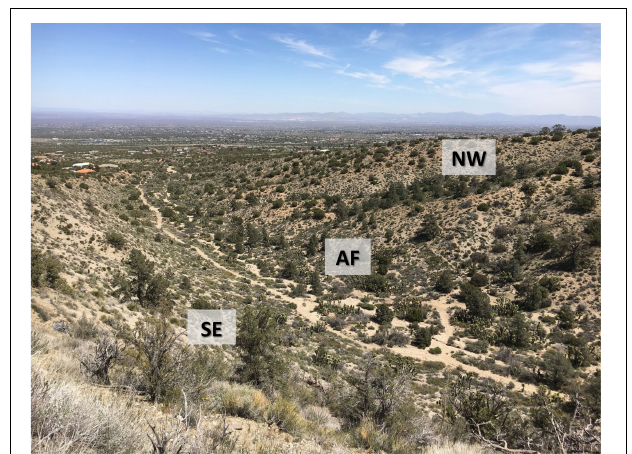
FIGURE 1 | Study sites in the West Mojave Desert. Overview of the three sites (NW, north-western slope; AF, alluvial fan; SE, south-eastern slope) in Puma Canyon in Piñon Hills, California. n = 3–8 individuals per species per